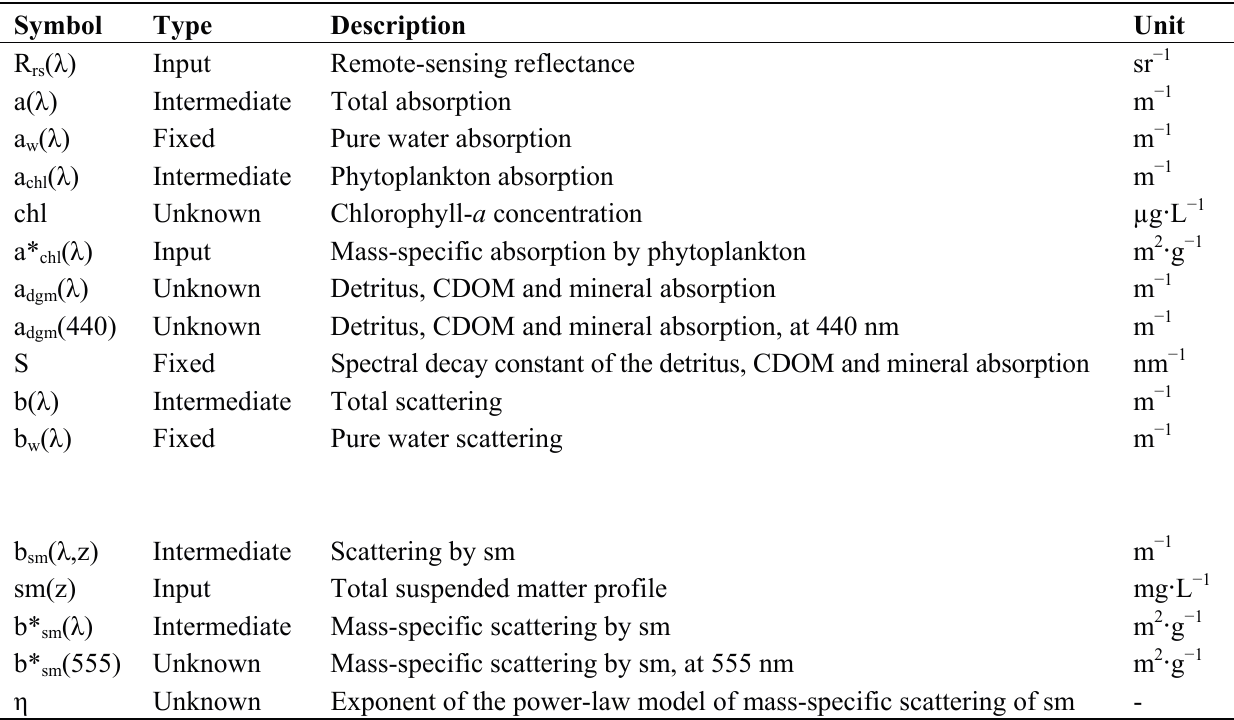
Table 1. Summary of variables used in the optical model, separated as fixed (assumptions from literature), unknowns (values calculated in the model), inputs (values defining the specific scenario to be simulated by the model) and intermediate (constructed from other variables, as part of the bio-physical